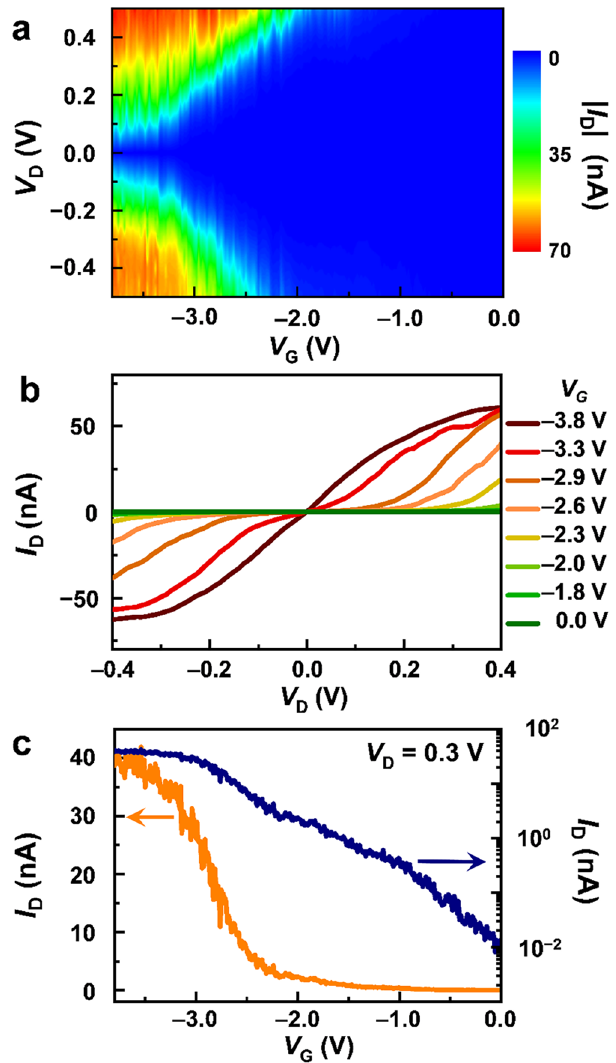
Fig. 3 Gate-controllable charge transport in Ru- o DAE single-molecule transistors. a Two-dimensional visualization of I D vs . V G and V D . b Representative I D – V D curves for different values of V G . c Transfer characteristics for the Ru- o DAE single-molecule FET at V D = 0.3